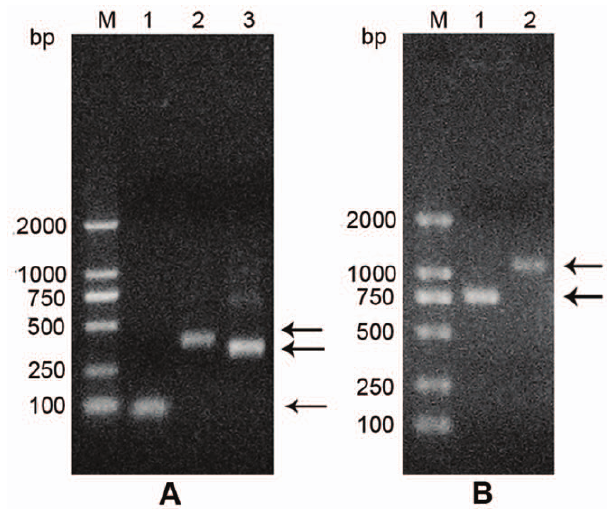
Figure 1. Agarose gel electrophoresis of amplified GS, VH,VL, scFv DNA fragment and assembled naive library. Arrows indicate DNA fragments positions. (A) Lane M: D2000 DNA marker, lane 1: GS fragments, lane 2: VH fragments, lane 3: VL fragments. (B) Lane M: D2000 DNA marker, lane 1: Assembled scFv DNA fragment, lane 2: 1.2 kb assembled naive